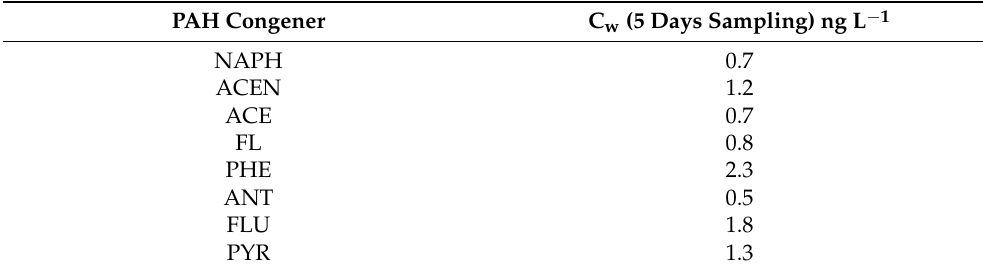
Table 3. The C w estimated for each PAH congener after 5 days of SPMDs’ exposure in the water body of the reservoir.